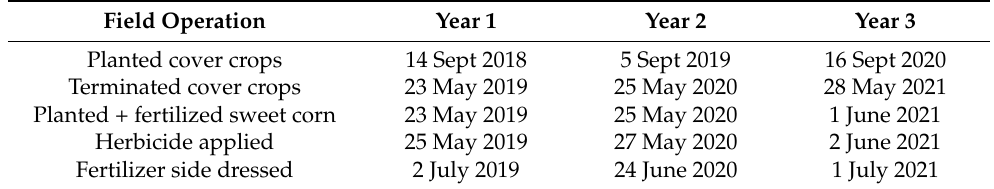
Table 1. Timing of field operations in 2019 (Upper Marlboro, MD), 2020, and 2021 (Beltsville,